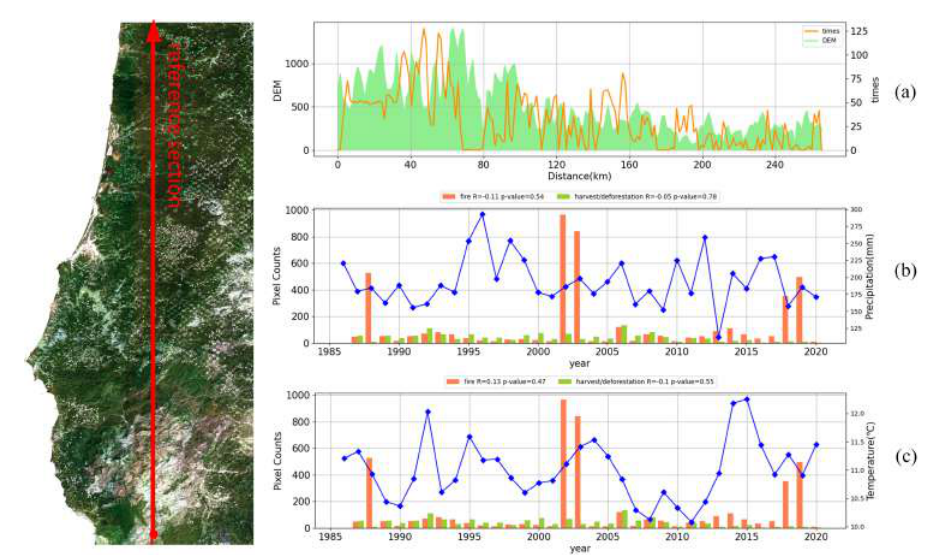
Figure 14. ( a – c ) Influences of terrain and weather factors on different types of forest